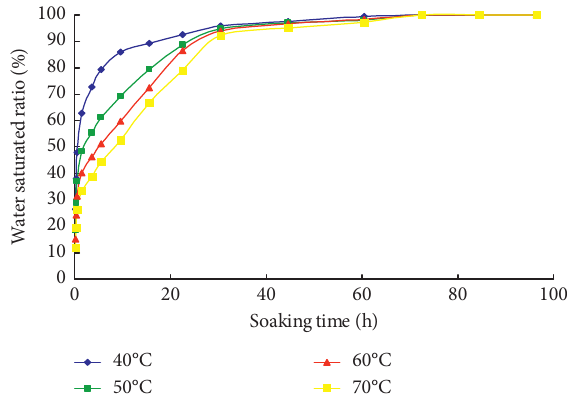
Figure 2: Relationship between saturated water ratio and soaking time.